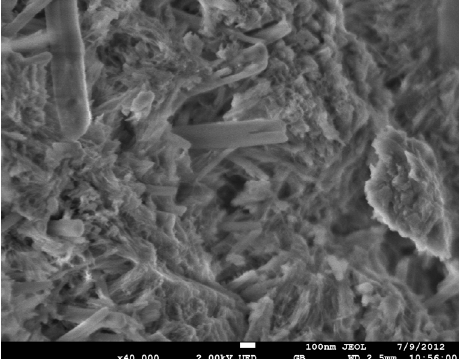
Figure 1: Image FESEM of cement. Figure 2: Image FESEM of cement mixed with 6%